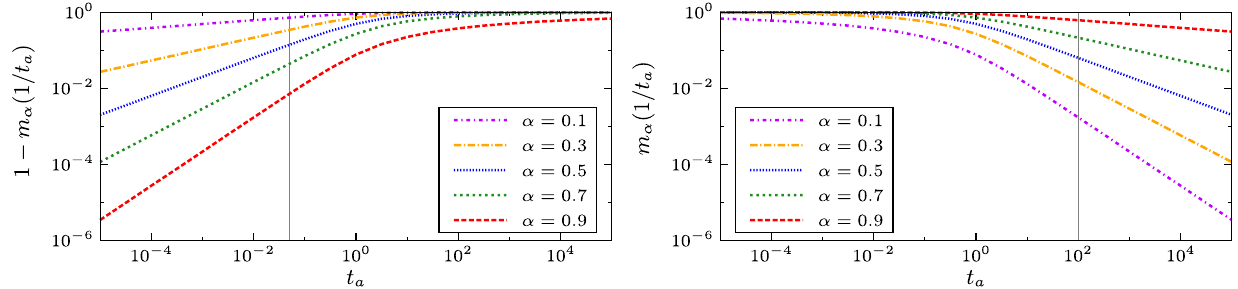
; t t (cid:1) a a þ at t ¼ 1 . The full analytic behavior is given by a 1 − α . Vertical lines indicate = 1 Þ α and the final power-law decay m α ≃ ð 1 =t a a Þ